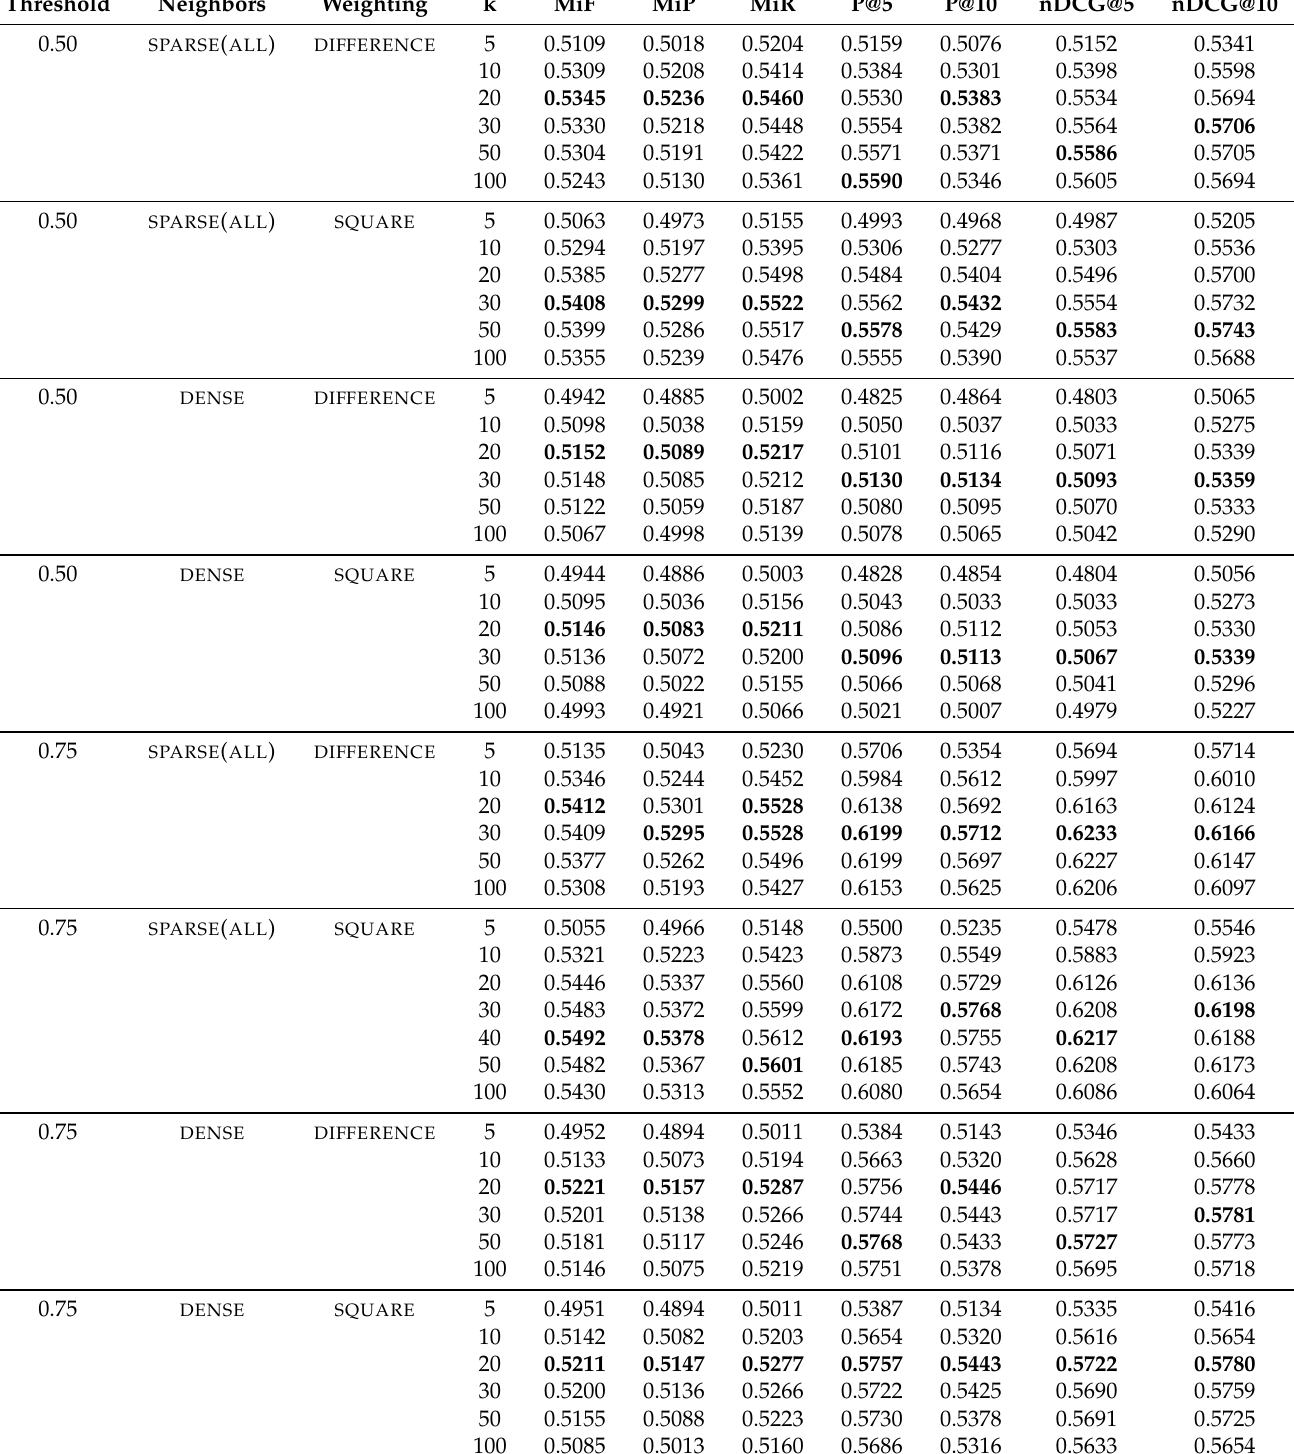
Table 8. Performance mixing results from basic k -NN with MEDIUM label-AE